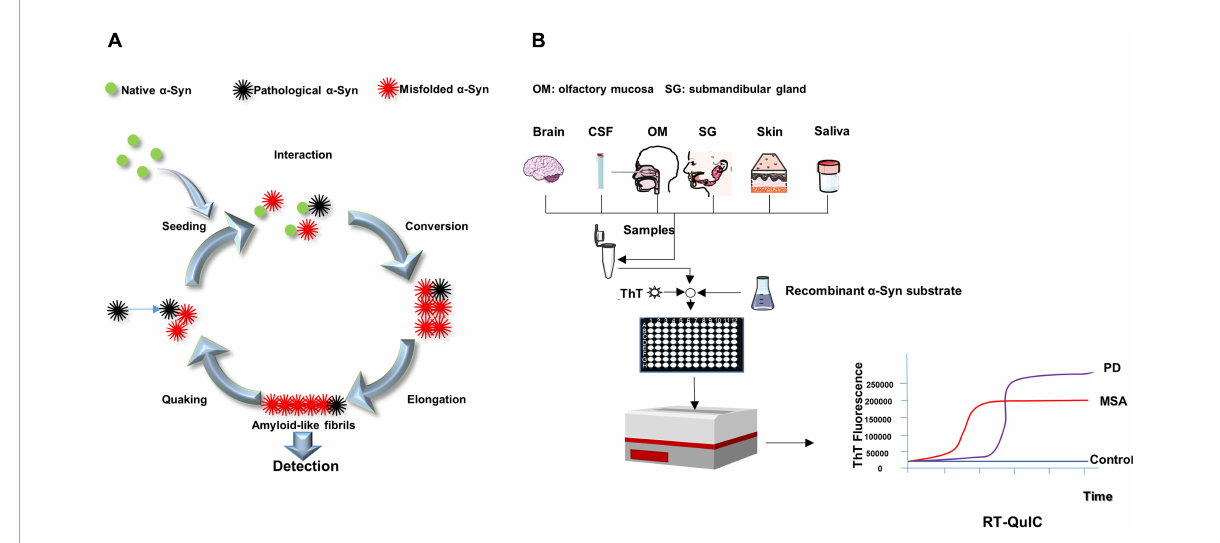
FIGURE2 Schematic presentation of RT-QuIC mechanism and process. (A) The pathological α -Syn seeds from patients (black) trigger conformational changes of native α -Syn (substrate, green) to form new misfolded α -Syn (red). The misfolded α -Syn proteins aggregate into oligomers, further elongating into fibrils. After the fibrils are detected, the quaking breaks the fibrils into shorter oligomers (seeds), which combine with other native α -Syn to promote the transformation again. (B) Samples are mixed with reaction buffer, including α -syn substance and thioflavin T (ThT, a fluorescent probe), loaded into a multi-well microplate and incubated in alternating cycles of shaking and rest in a fluorescence microplate reader. The device records real time ThT fluorescence emission. A sigmoidal growth in ThT fluorescence reveals synucleinopathies. The difference of lag period and maximum of ThT fluorescence could be used to distinguish MSA from